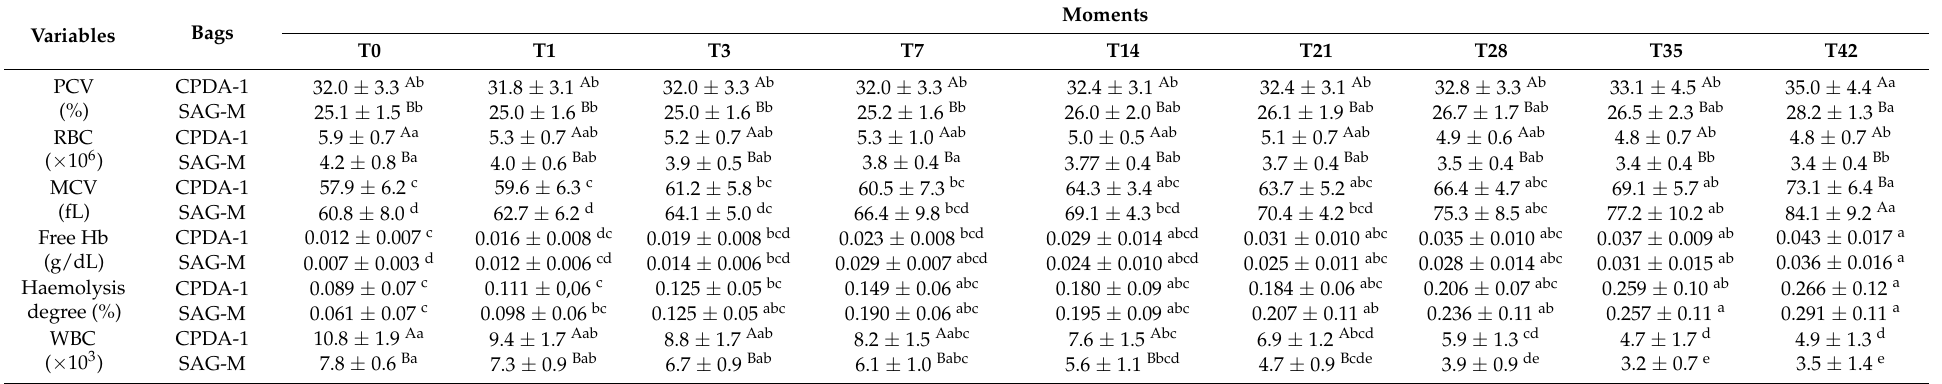
Table 1. Mean and standard deviation values of hematological variables of donkey whole blood stored in CPDA-1 and CPD/SAG-M bags for 42 days. Variables